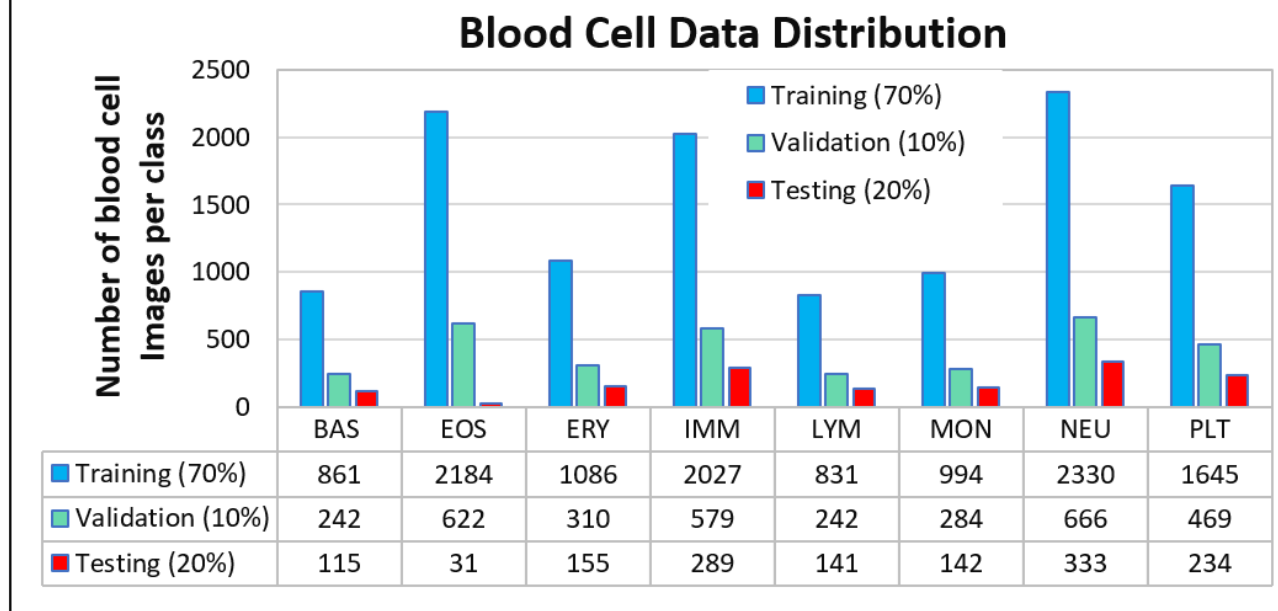
Figure 2. HPBC dataset distribution over eight different classes of the human peripheral blood cell (HPBC) images. The images were randomly split per class into 70% (training), 10% (validation), and 20% (testing).